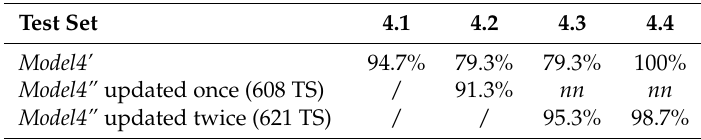
Table 7. The classification accuracies of Model4” after the retraining process.